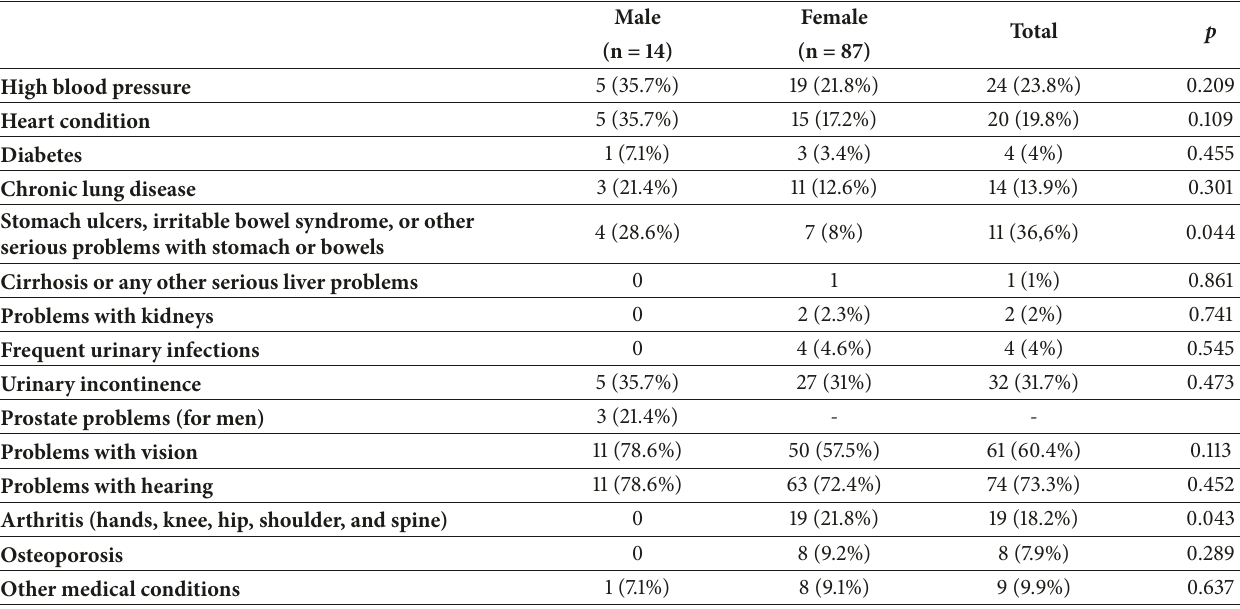
Table 3: Current health problems of the centenarians of Beira Interior ( 𝑁 = 101).